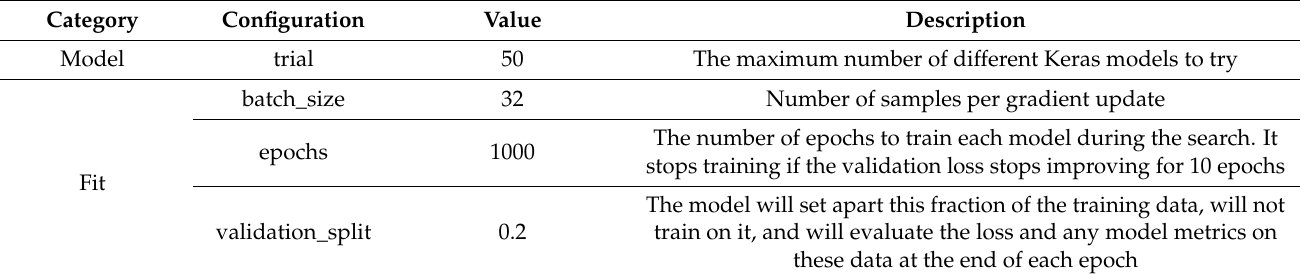
Table 2. Training configuration parameters.